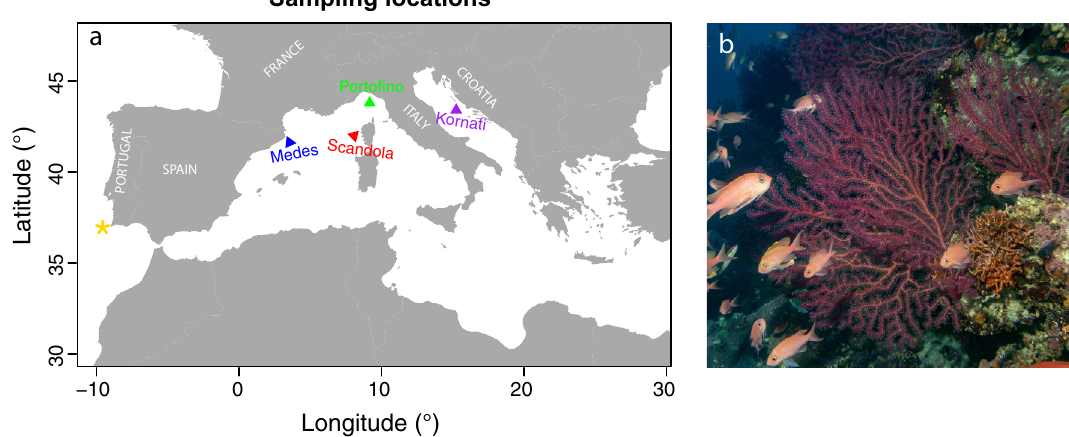
Figure 1. ( a ) Location of the four sampling localities across the Mediterranean. * Another population from Sagres (Portugal) was initially included in the thermal experiment, but was withdrawn from the analyses after recently confirmed to be a different species of Paramuricea. ( b ) Photo of the study species Paramuricea clavata (photo by Medrecover). The map shown in panel ( a ) was generated using R software version v3.5.0 (https, //www.R- proje ct. org/) and combined with the photo in panel ( b ) using Adobe Illustrator CC 2018 (https:// adobe. com/ produ cts/ illus trator).